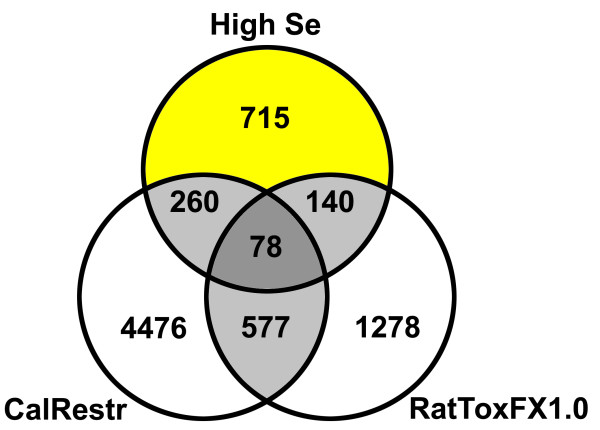
Identification of Se-specific probe sets regulated by 5 μg Se/g diet. The 1193 probe sets that were changed significantly by 5 μg Se/g diet in rat study 2 as compared to 0.24 μg Se/g diet were filtered to remove 260 non-specific transcripts overlapping with probe sets changed significantly by caloric restriction (CalRestr), to remove 140 transcripts included in the RatTox FX 1.0 array, and to remove 78 transcripts found in both datasets. The resulting 715 high Se-transcript dataset contains 48 duplicate transcripts, yielding 667 unique transcripts which correspond to 437 unique genes.